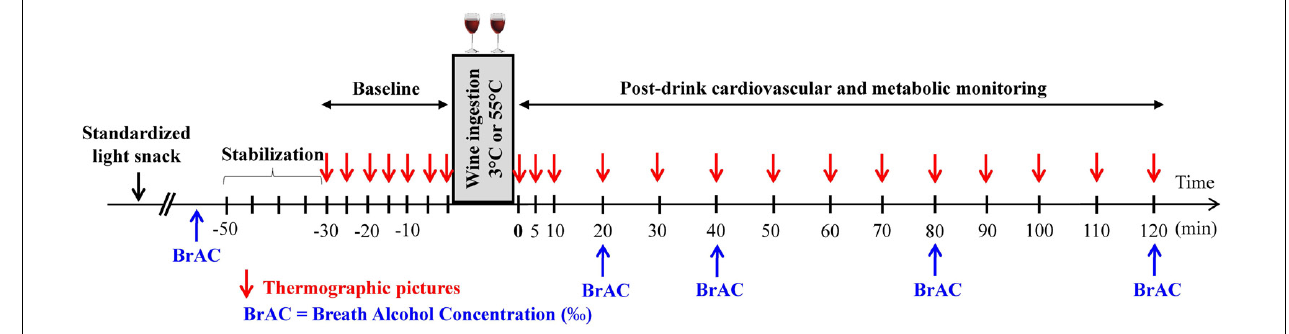
FIGURE 1 | Study design indicating the time at which measurements of breath alcohol concentration (BrAC) and thermographic pictures were done.